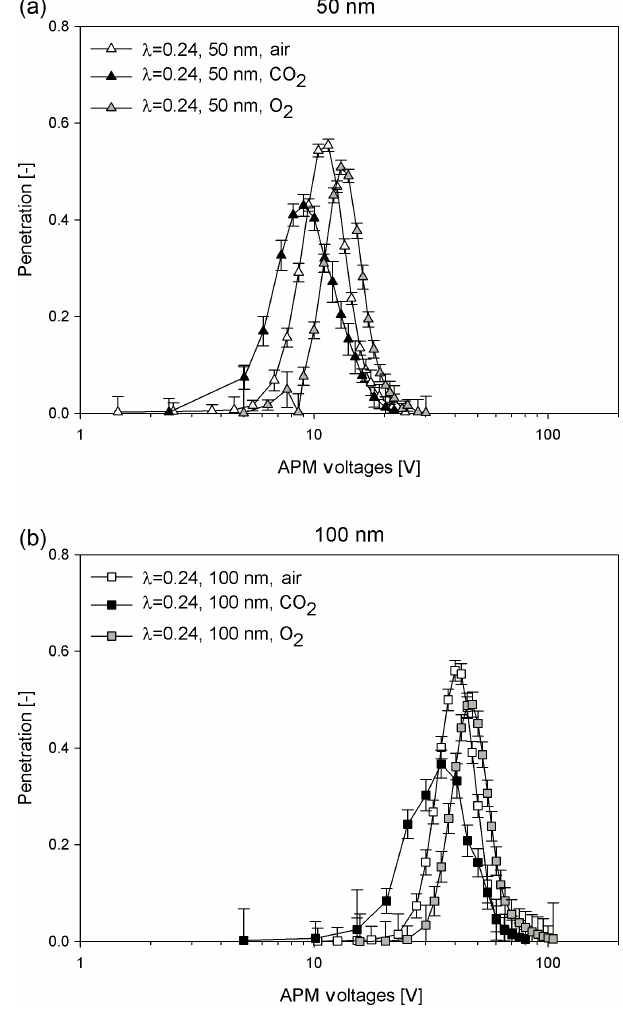
Figure 5. APM experimental transfer function of 50 and 100nm PSL spheres for various carrier